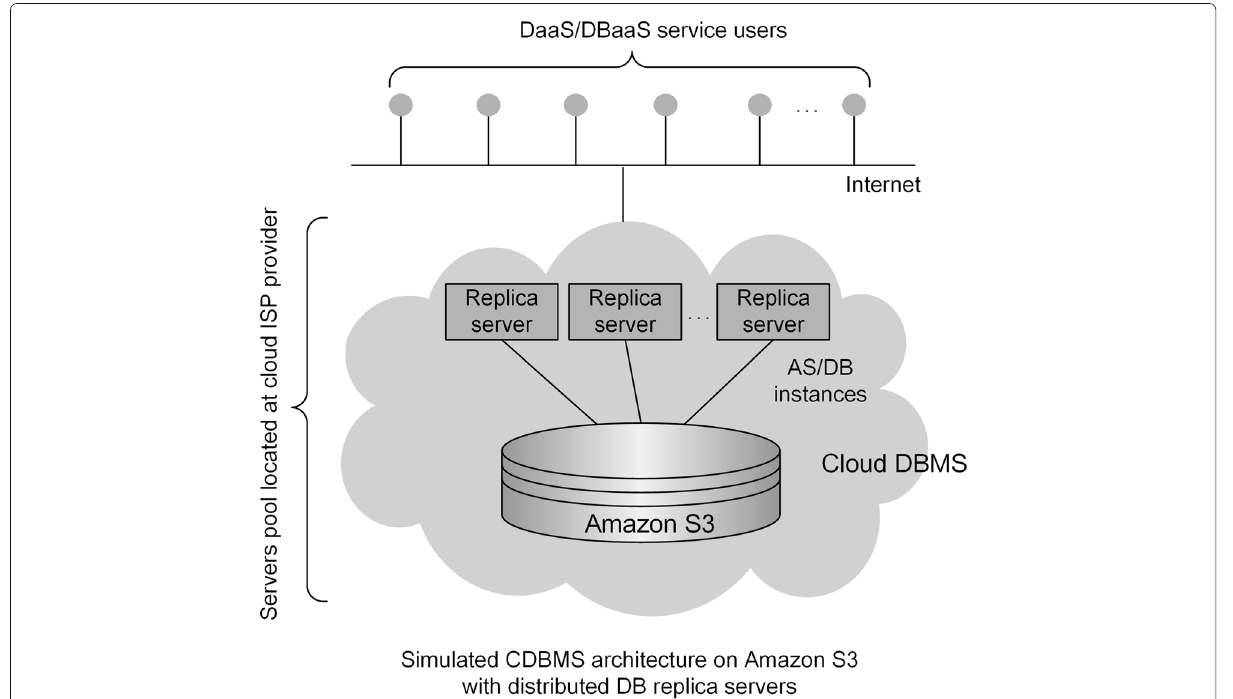
Fig. 13 Simulation environment and cloud DBMS architecture for the performed experiment and validation of the results of the proposed advanced R-TBC/RTA